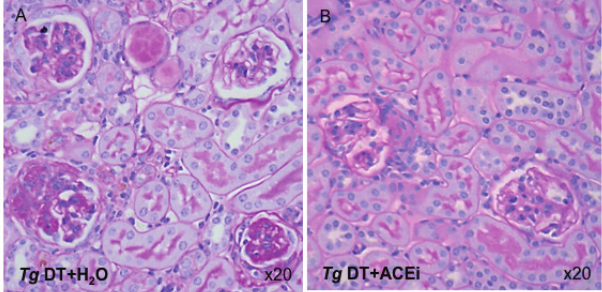
Figure 7. Kidney histology of ACEi treated and untreated Podo- DTR line 57 mice. ( A ) Cluster of 4 glomeruli with varying degree